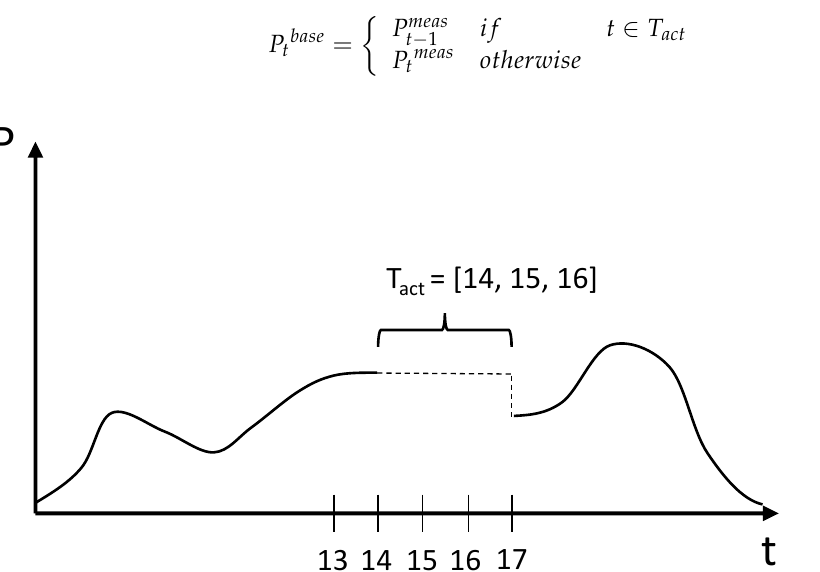
Figure 3. Illustration of baseline I and its activation period. The dashed line reflects the